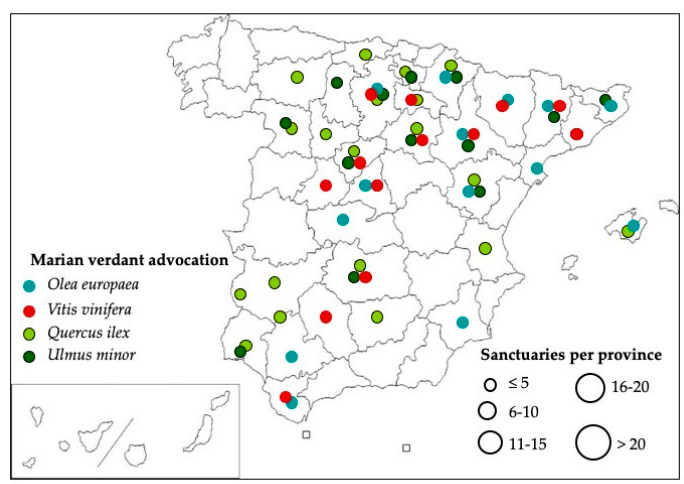
Figure 4. Geographical distribution of Olea europaea , Vitis vinifera , Quercus ilex , Ulmus minor .